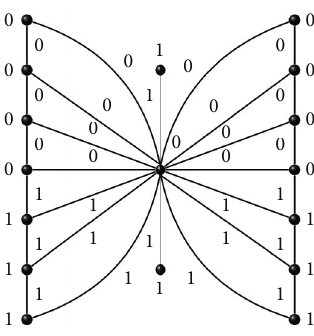
Figure 5: Total edge product cordial labeling of Dg